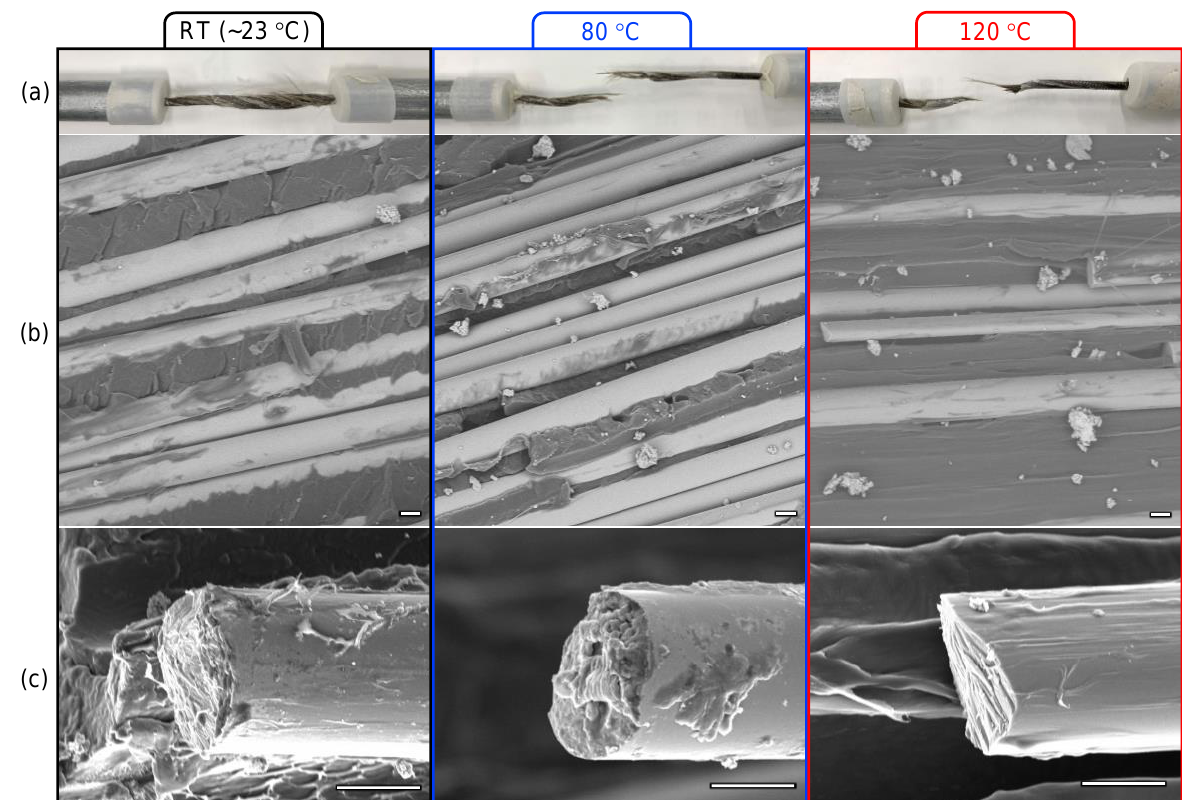
Figure 4. Observation of fractured specimens at higher temperatures: ( a ) specimen appearance after tensile testing, ( b ) fiber and matrix condition, and ( c ) fracture surface of individual fibers (all scale bars are 10 μm).